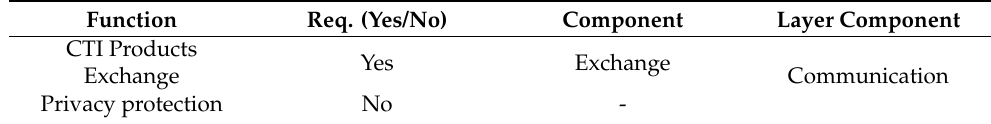
Table 8. Application of CTI Reference Model: Communication Layer.